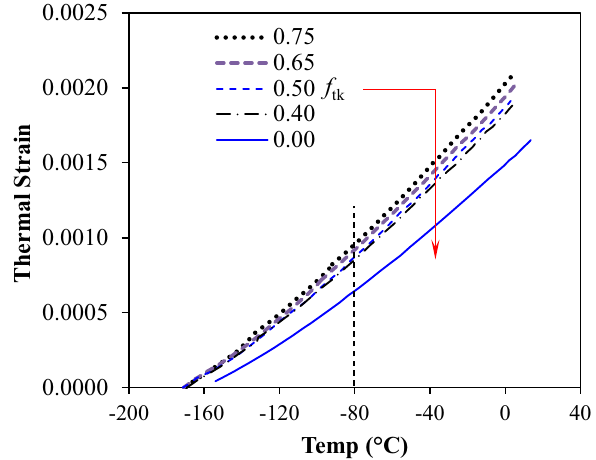
Fig. 3 Temperature versus thermal strain relationship during heating process.